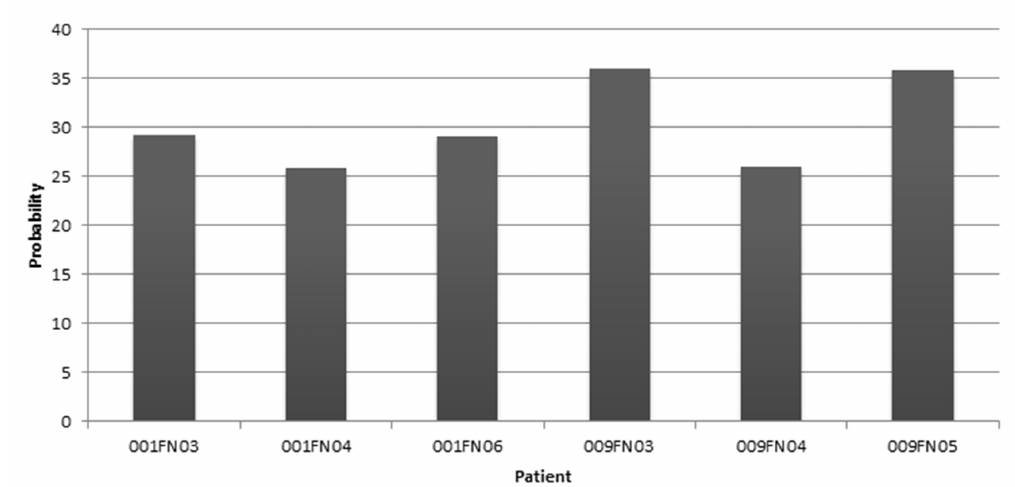
Figure 5. Probability of stimulation. Results of corticomuscular coherence from patient 001 (presenting a Parkinsonism of vascular origin) and from patient 009 (presenting essential tremor). Three trials were analyzed for each patient.